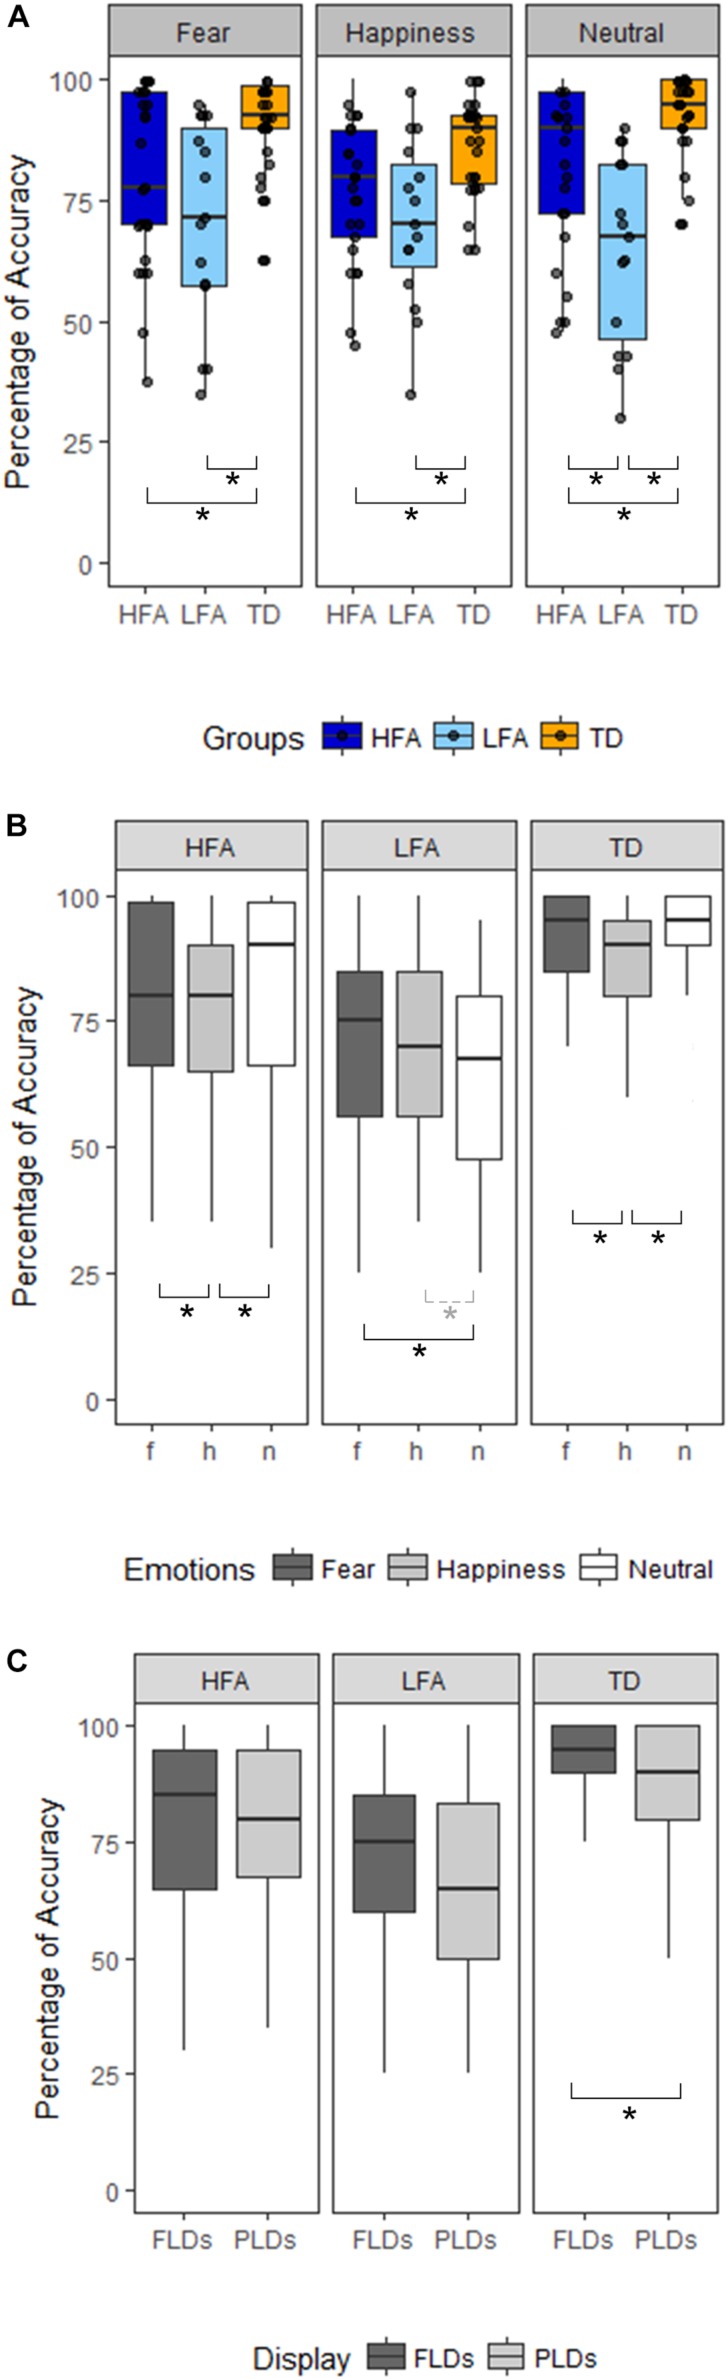
Panel(A) shows the differences between the three groups of children (HFA: ASD without ID, LFA: ASD with ID; TD: typical developing) in the three emotional categories (Happiness, Fear, and Neutral). The black dots represent the percentage of Accuracy of every participant in the relative emotional category. Panel (B) shows within-group differences between the emotional categories (dark-gray for Fear, light-gray for Happiness, white for Neutral stimuli). Panel (C) shows within-group differences between the Display type (FLDs in dark-gray, PLDs in light-gray). In all the Panels, the boxes represent the interquartile range, the black horizontal lines represent the median, the black vertical bars represent the standard error. The black stars represent the significant differences (p < 0.05), the dashed line and gray star represent the marginally significant differences (0.05 < p < 0.01).